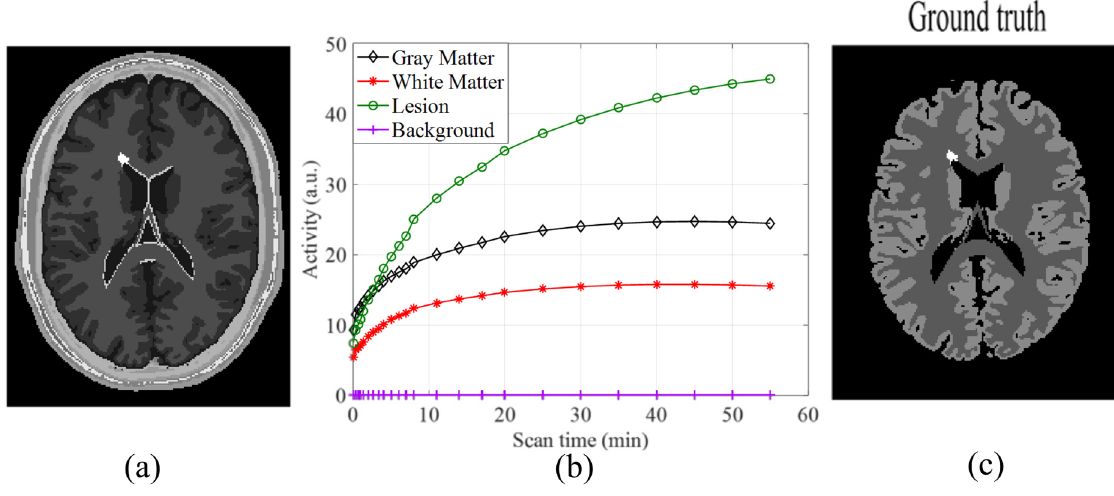
Fig 1. (a) Anatomical model, (b) time activity curves, (c) simulated PET activity image at the end of scan. The bright spot in (a) and (c) is a lesion simulated and inserted by BrainWeb.